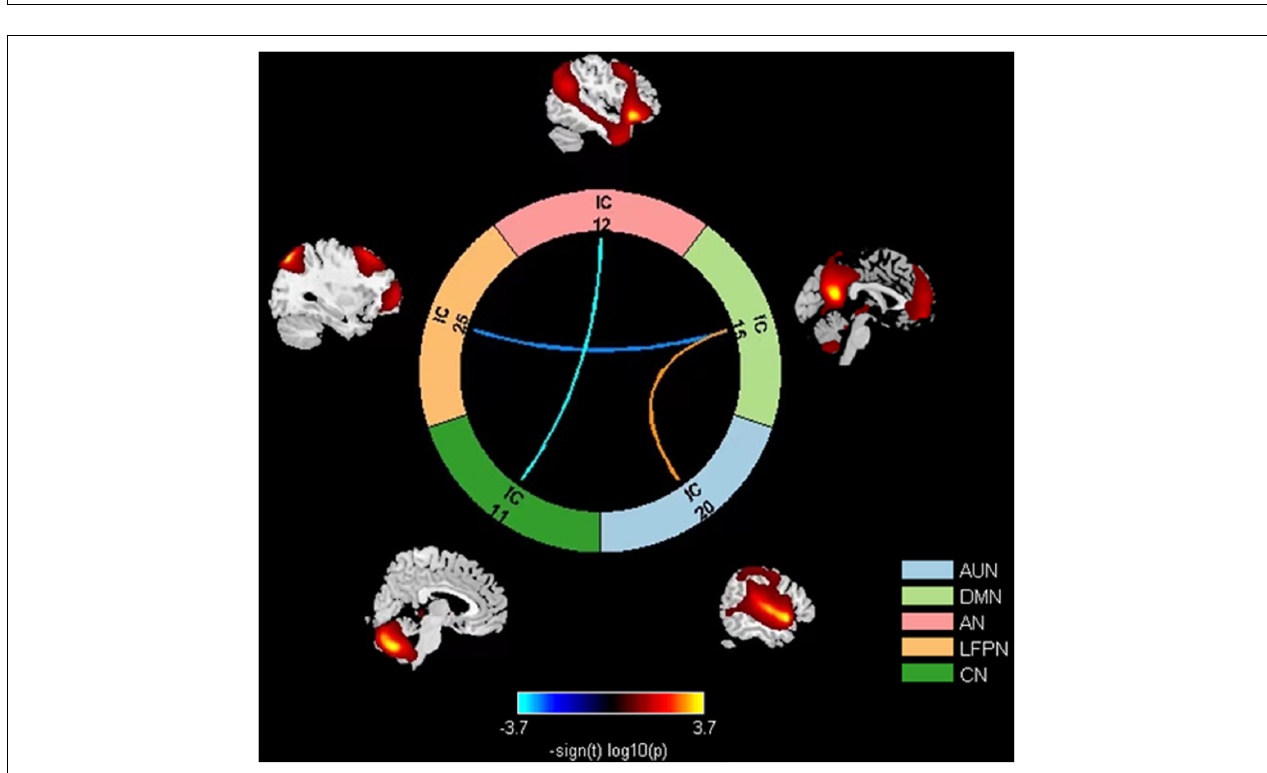
FIGURE 3 | Group comparison results of sFNC between eight RSNs: decreased sFNC in the DMN (IC15)-LFPN (IC25) and AN (IC12)-CN (IC11) pairs and increased sFNC in the AUN (IC20)-DMN (IC15). sFNC, static functional network connectivity; DMN, default mode network; LFPN, left frontoparietal network; AN, attention network; CN, cerebellum network; AUN, auditory